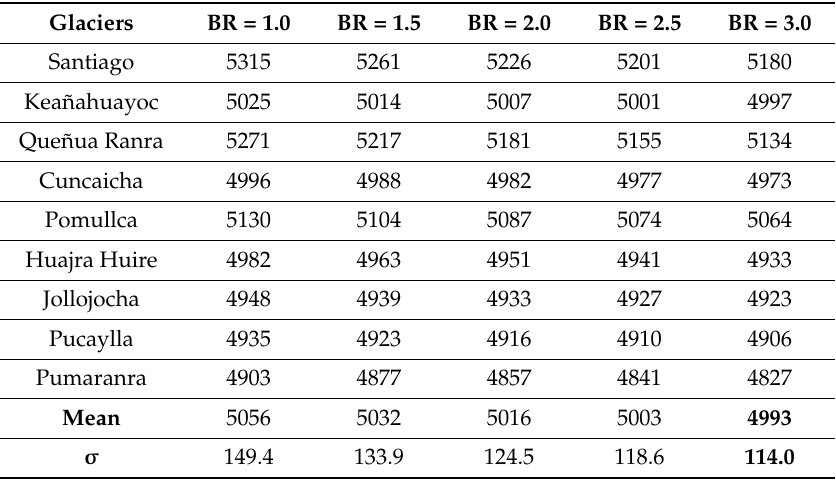
Table 4. PaleoELA 2 (all mapped glaciers) and BR applied. Glaciers BR = 1.0 BR =